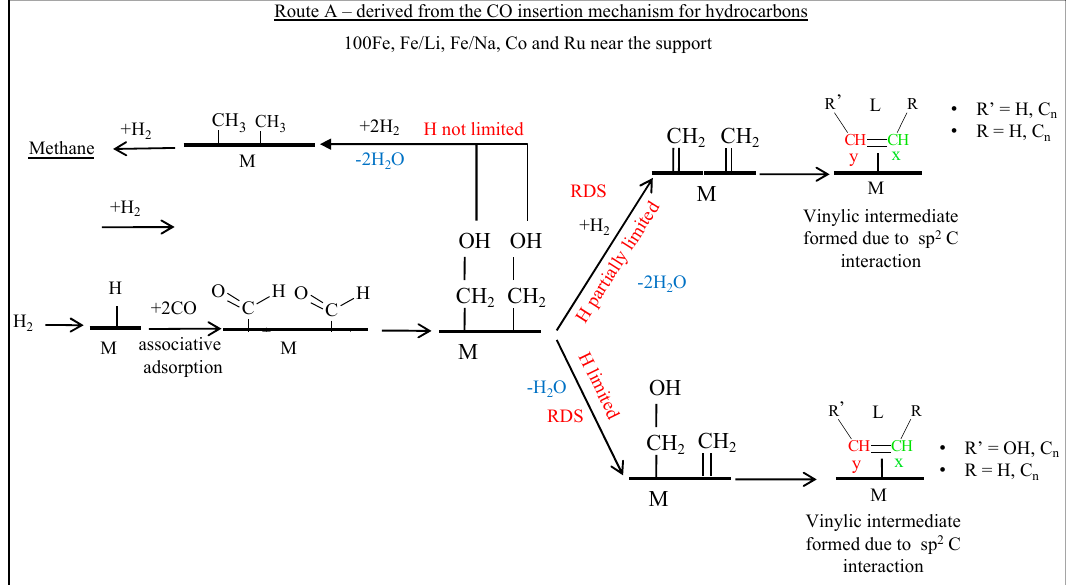
Figure 39. Proposed route A for the formation of several products observed in FTS, based on the CO insertion mechanism. Mechanistic routes for methane will be preferred when the back-donation of electron density from the metal is poor. This weak back donation does not easily allow for the vinylic intermediate to be formed or stabilized to the extent that is needed for chain growth. Furthermore, if the back-donation of electron density from the metal is too great (as with an activated nickel catalyst), then CO will dissociatively adsorb, and the vinylic intermediate, if formed, will be easily dissociated back to C 1 , to again prefer methane formation. Thus, the careful tuning of electron back donation from the metal must be maintained to achieve desired chain growth.